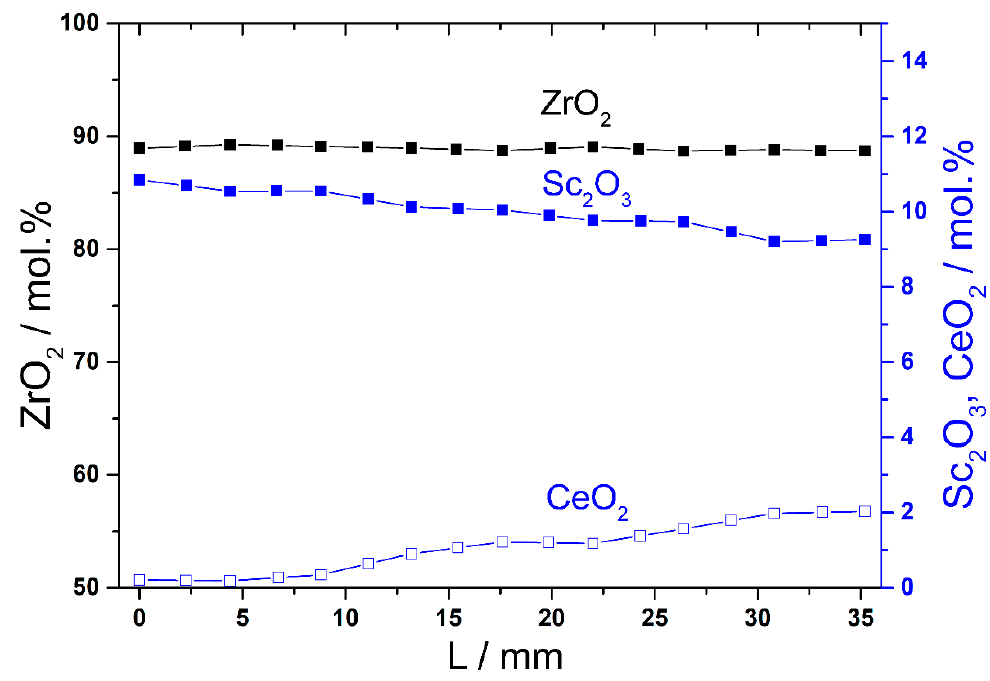
Figure 2. Zirconia scandia and ceria distribution along the length of the crystal